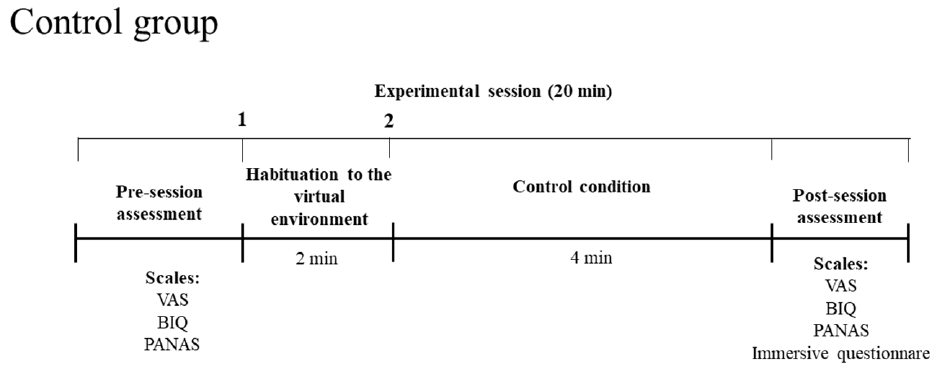
Figure 5. Timeline of each experimental session for the control group.